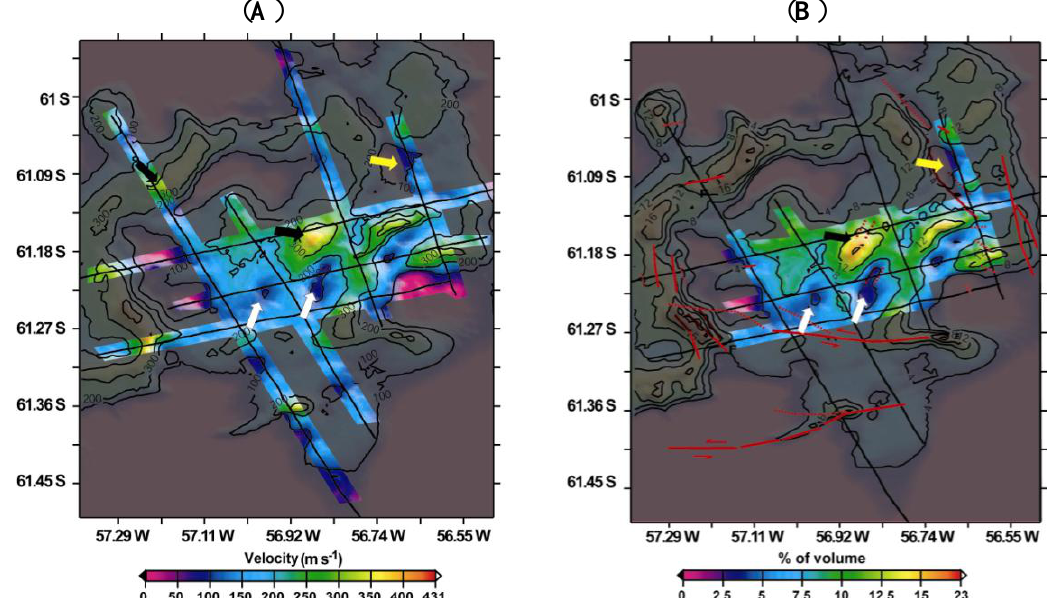
Figure 7. ( A ) Map of velocity anomalies extracted just above the BSR. Contour lines are plotter every 50 m. White arrows indicate low velocity anomalies; black arrow indicate the high velocity anomalies; and yellow arrow indicate the Mud Volcano Vualt; ( B ) Map of the gas hydrate amount extracted just above the BSR. Contour lines are plotter every 2%. White thick arrows indicate low gas hydrate amount corresponding to the low velocity anomalies, and black arrow indicates the high gas hydrate amount. A mask is over-imposed on the images to visualize the reliable area. The structural interpretation was over-imposed as red solid and dashed